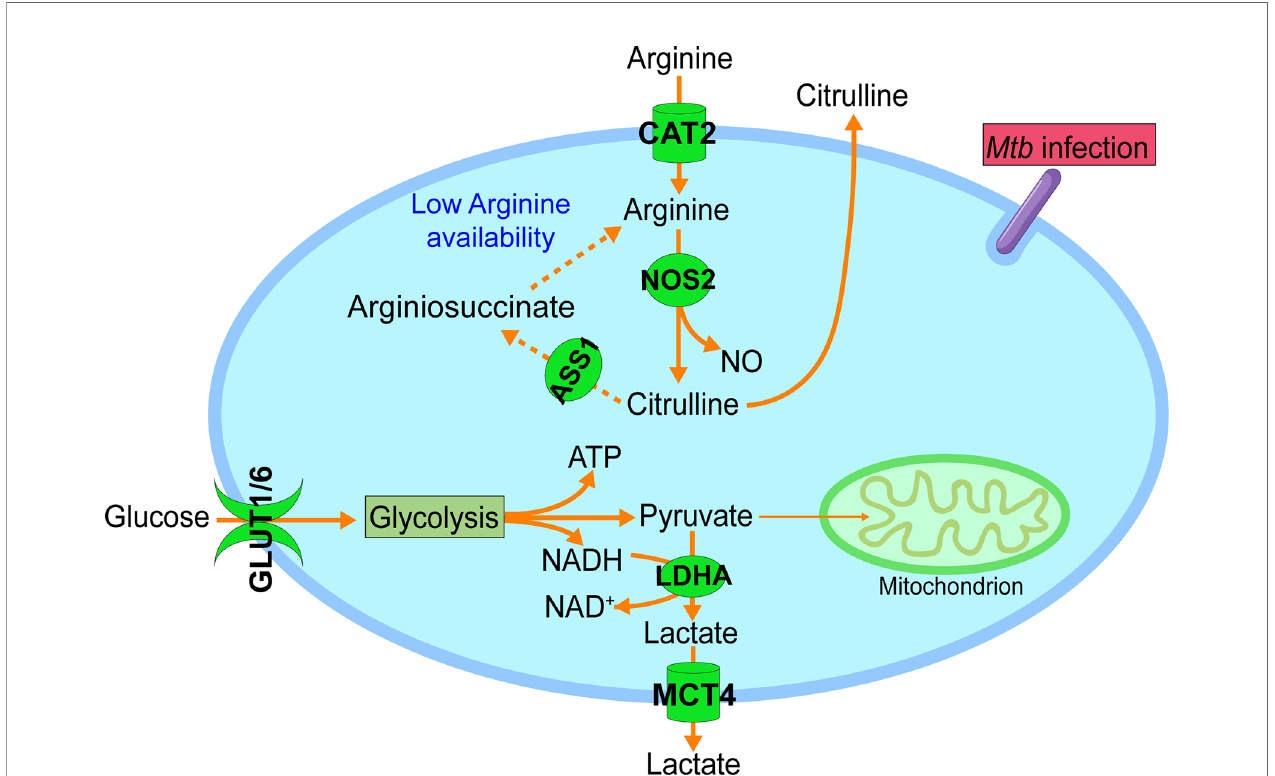
FIGURE 1 | Increased arginine uptake and metabolism during M1-like polarization. In addition to the metabolic reprogramming to glycolysis with increased glucose uptake (GLUT1 & GLUT6) and lactate formation (LDHA) and secretion (MCT4), M1-like polarization is also accompanied by increased uptake and metabolism of arginine. Increased expression of cationic amino acid transporter 2 (CAT2) mediates the import of arginine from the extracellular microenvironment. Intracellular arginine is mainly catabolized by upregulated inducible nitric oxide synthetase 2 (NOS2) to NO and citrulline, and the latter is actively secreted to the extracellular microenvironment. With the decreasing availability of extracellular arginine, NOS2-derived citrulline is recycled for the regeneration of intracellular arginine via argininosuccinate synthetase 1 (ASS1) (dashed line), which will sustain the NO production by NOS2. GLUT1, glucose transporter 1; GLUT6, glucose transporter 6; LDHA, lactate dehydrogenase A; MCT4, monocarboxylate transporter 4 (MCT4). Data were derived from references and/or supplementary fi les therein (27 –